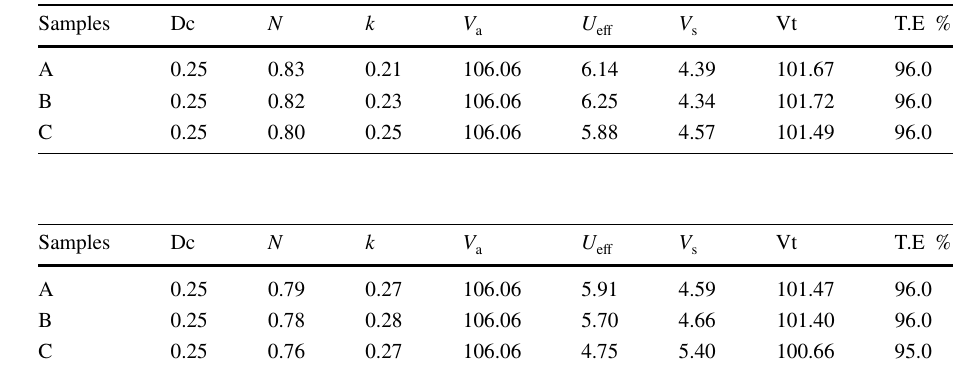
Table 21 Evaluation of V V